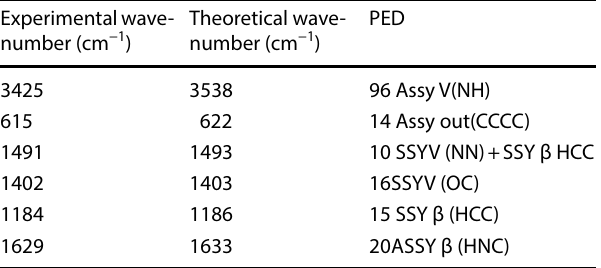
Table 1 Experimental and theoretical vibrational energy distribu- tional analysis of the studied compound Experimental wave- number (cm −1